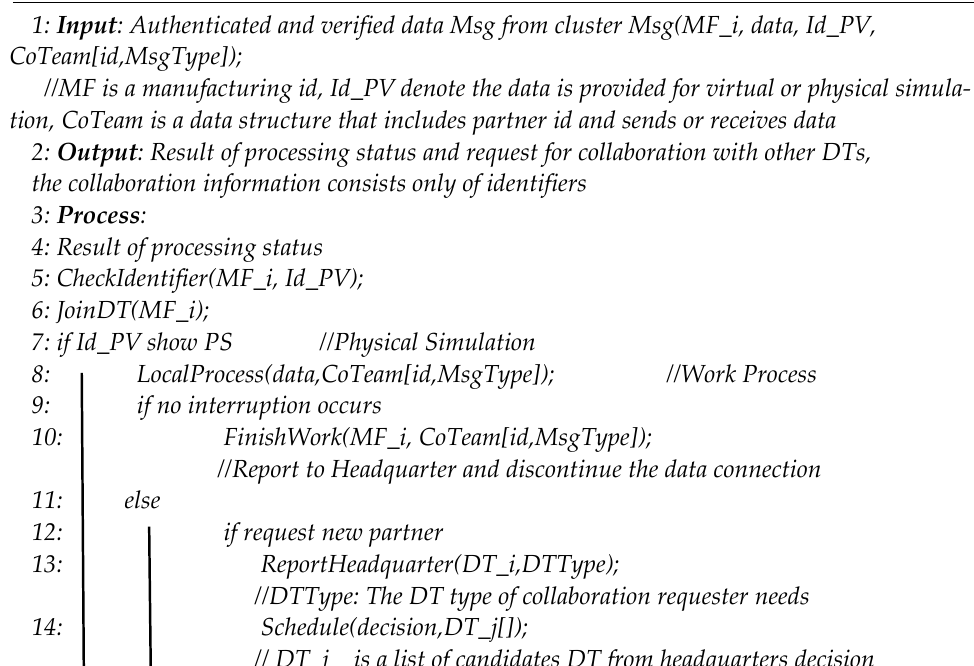
Algorithm 2. Digital Twin ‐ based Algorithm 2 Digital Twin-based Scheduling